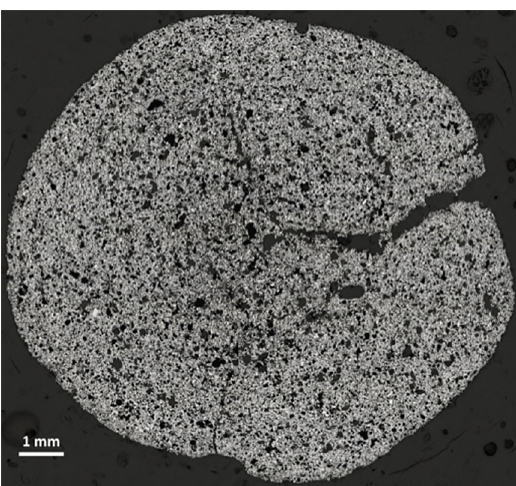
Figure 4. Optical microscope image mosaic covering the entire cross section of a pellet. 4X lens for the same pellet. Figures 5e and 5f compare the area and volume imaged with the two lenses. The smaller VOI is roughly 1/9 of the larger one.